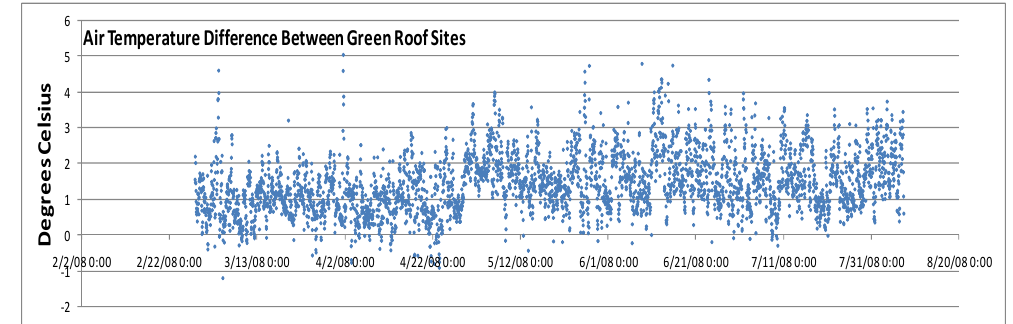
Figure 8. Hourly air temperature differences between the two green roof projects shown